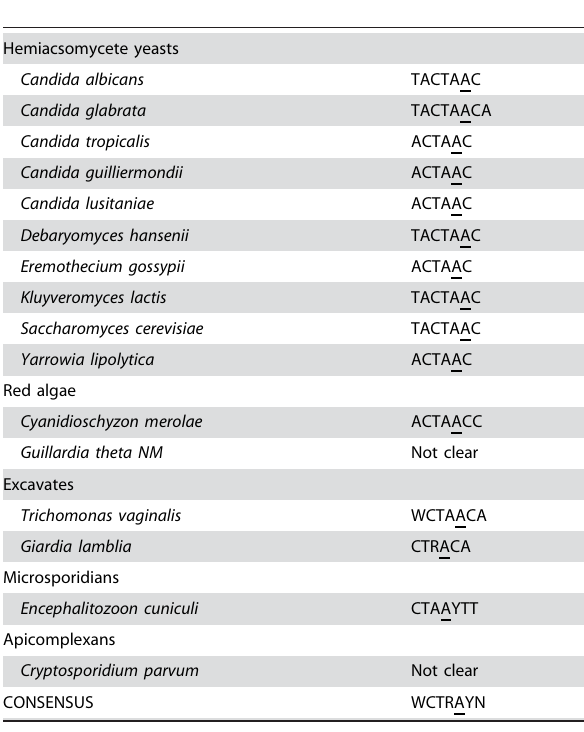
Table 1. Putative branch point consensus in the 16 studied intron-poor